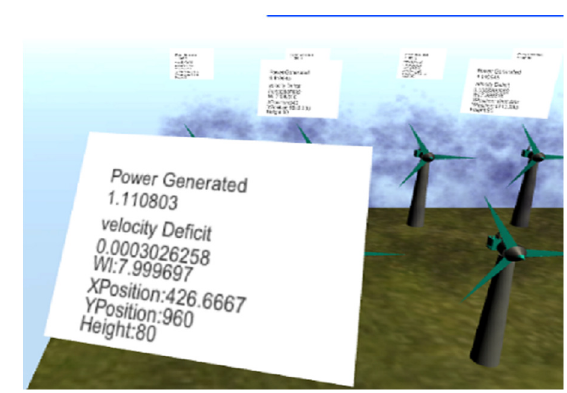
Fig. 7: Power and Wind Input graph